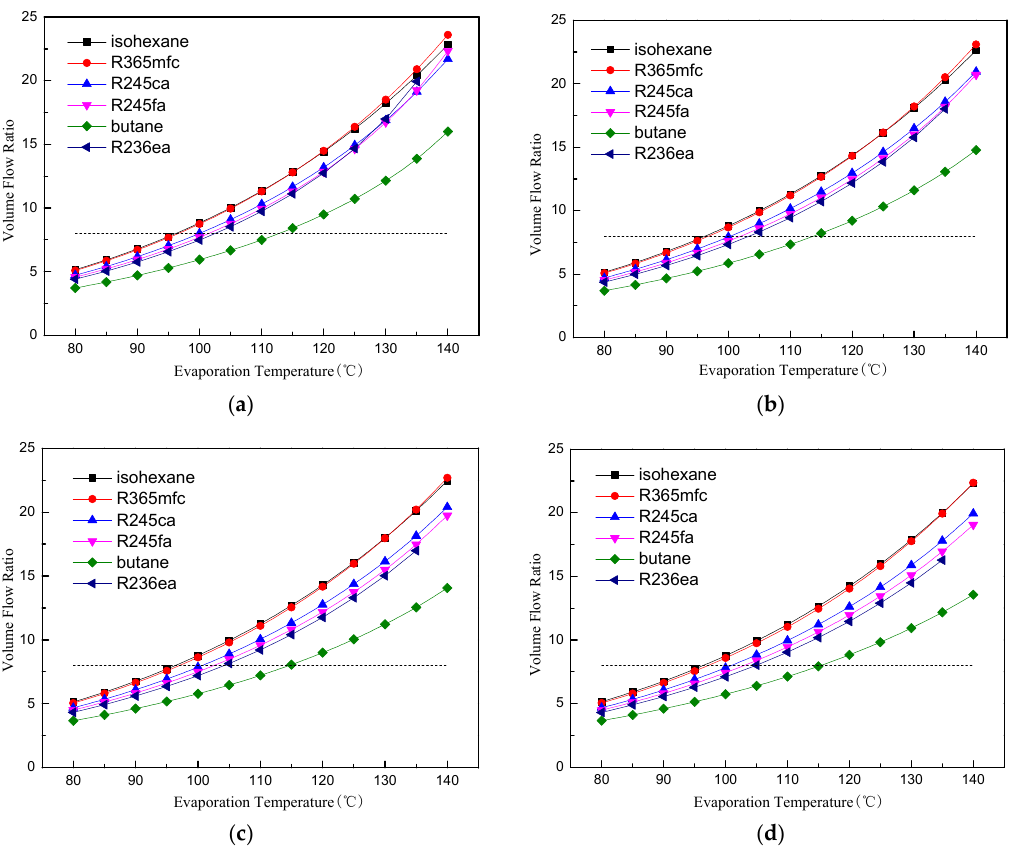
Figure 7. Variations of variation flow ratio with evaporation temperature at four different degrees of superheat: ( a ) 0 °C degree of superheat; ( b ) 5 °C degree of superheat; ( c ) 10 °C degree of superheat; superheat: ( a ) 0 ◦ C degree of superheat; ( b ) 5 ◦ C degree of superheat; ( c ) 10 ◦ C degree of superheat; and ( d ) 15 °C degree of superheat. and ( d ) 15 ◦ C degree of